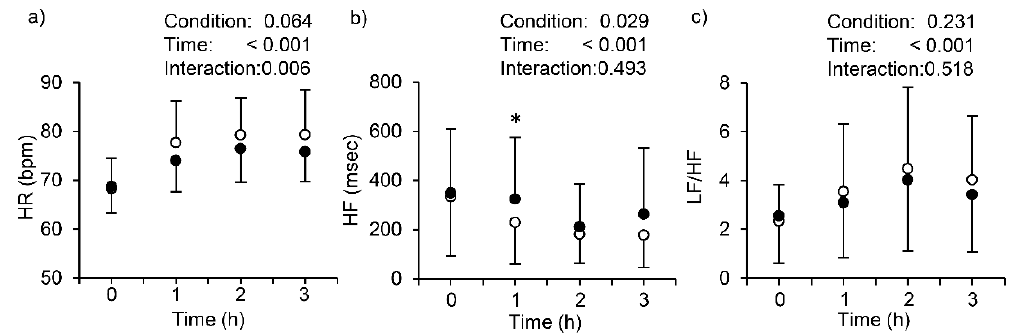
Figure 3. Changes in heart rate (HR; panel a ) and HR variability (HF; panel b and LF/HF; panel c ) with vs. without stockings. Values are mean ± SD. Each symbol means the same as in Figure 2. HR, heart rate; bpm, beats per minute; HF, high-frequency oscillations, LF/HF, the ratio of low- and high-frequency oscillations. The 0 on the X axis indicates the point between 5 and 10 min into a 3-h sit. * indicates a significant difference between with and without stockings at 1 h.